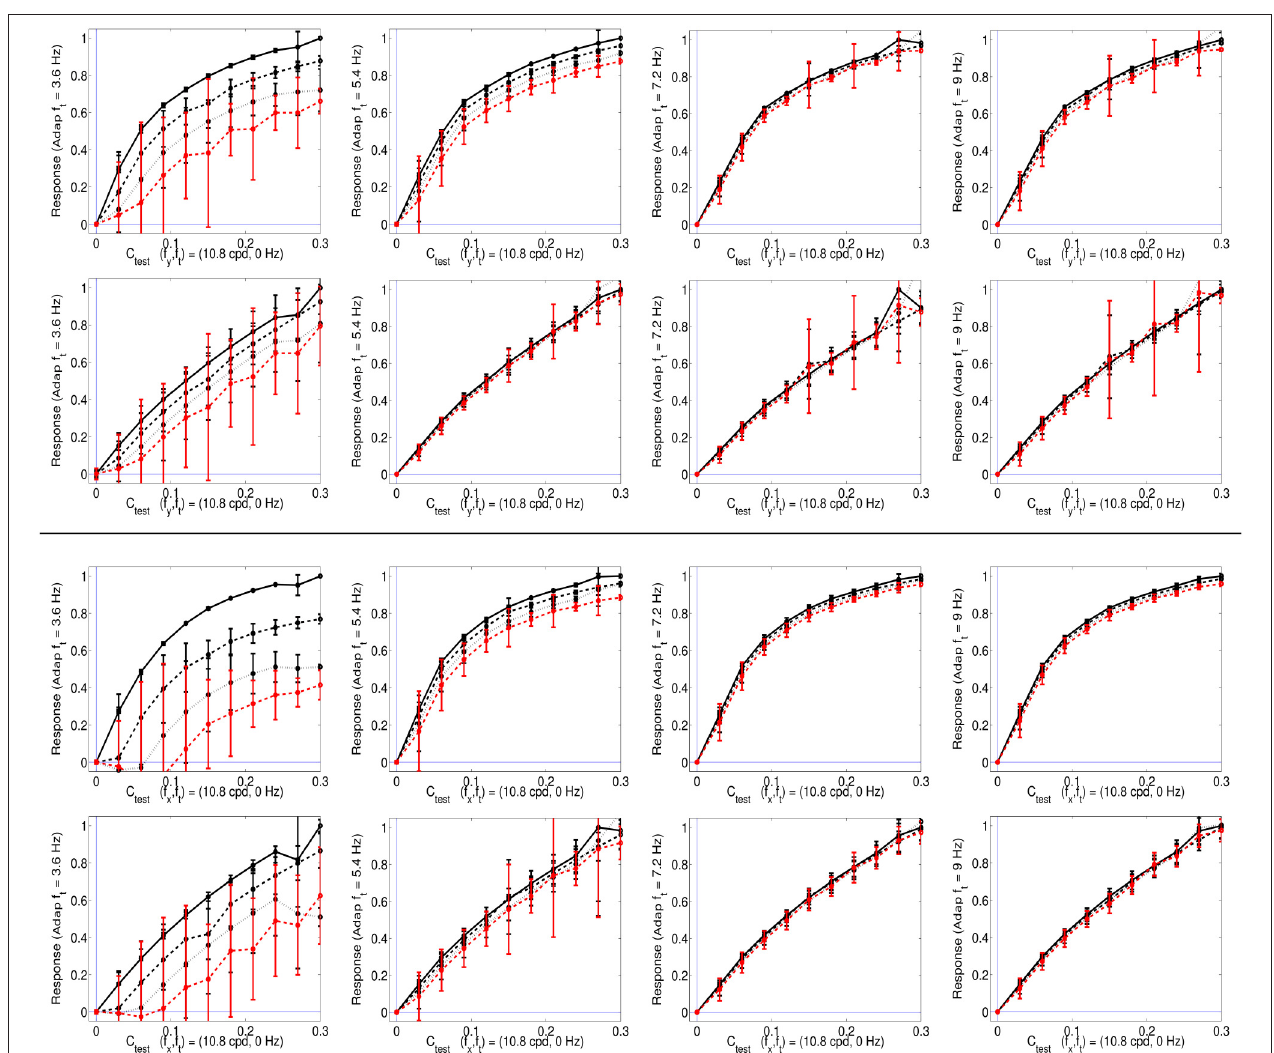
FIGURE 5 | Responses of SPCA sensors tuned to f t = 0 in environments where other moving patterns are present. Top (1st and 2nd rows) responses with adaptation to vertical speeds. First row displays the response of SPCA tuned for infomax while second row shows the equivalent results for SPCA sensors with minimum representation error. In every row, the vertical speed of the adapting stimulus increases from left to right. As in Figures 2 , 4 , different line styles correspond to the responses in different environments: the solid black line corresponds to responses to isolated static stimuli, and the other line styles correspond to responses of the same sensor in environments where there is also a moving pattern of progressively greater contrast: from the dashed-black line (moving adaptor with small contrast), to the dashed-red line (moving adaptor with greater contrast). The curves are the average over equivalent stimulations (phase and speed sign). Error bars indicate standard deviation. Bottom (3rd and 4th rows) equivalent responses with adaptation to horizontal